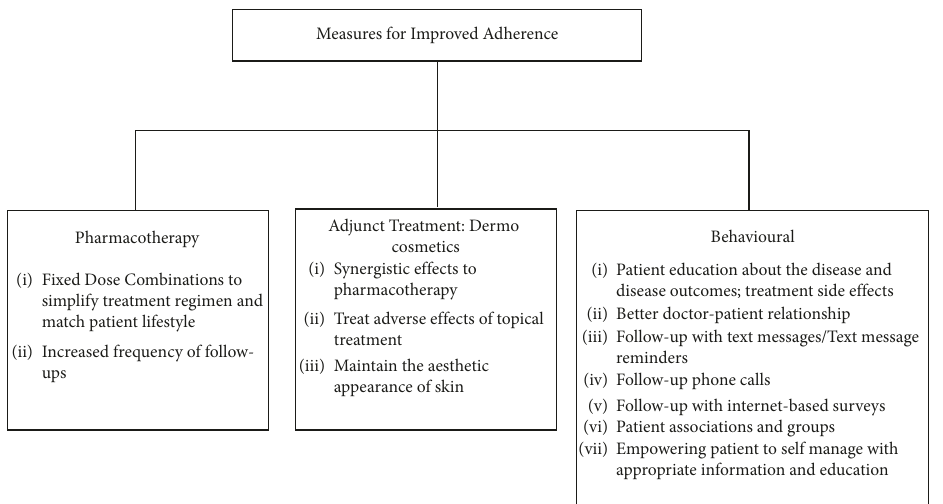
Figure 2: Methods to improve